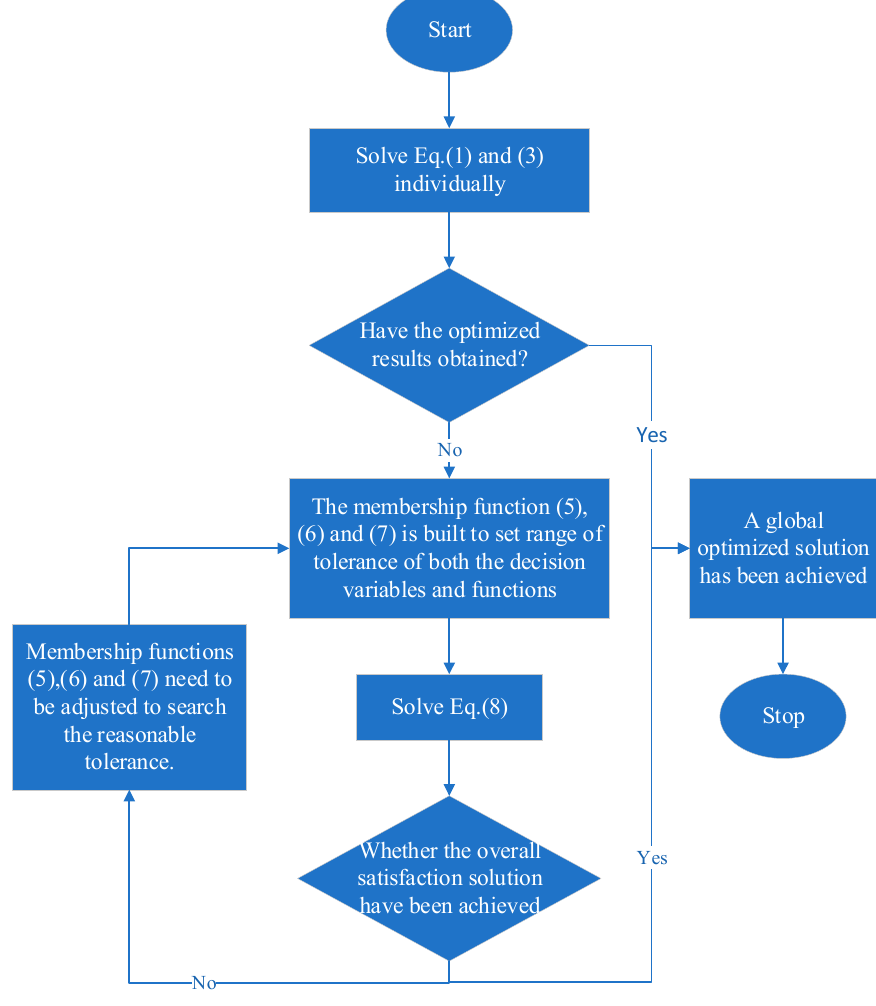
Figure 1. The flow chart of the PCIO model